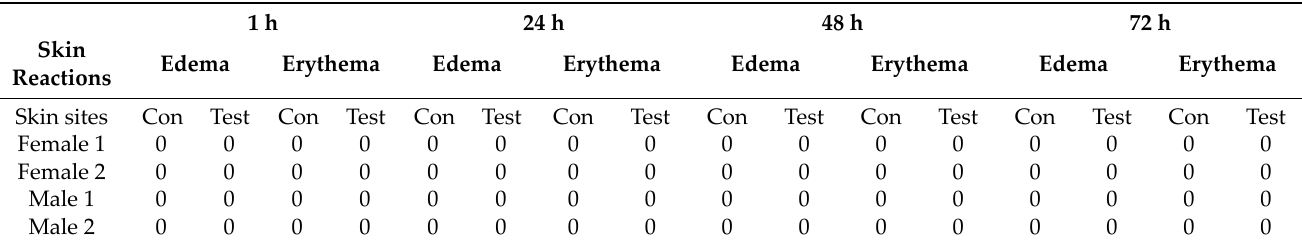
Table 1. Scores of edema and erythema of control (Con) and test (Test) sites of four rabbits at various time